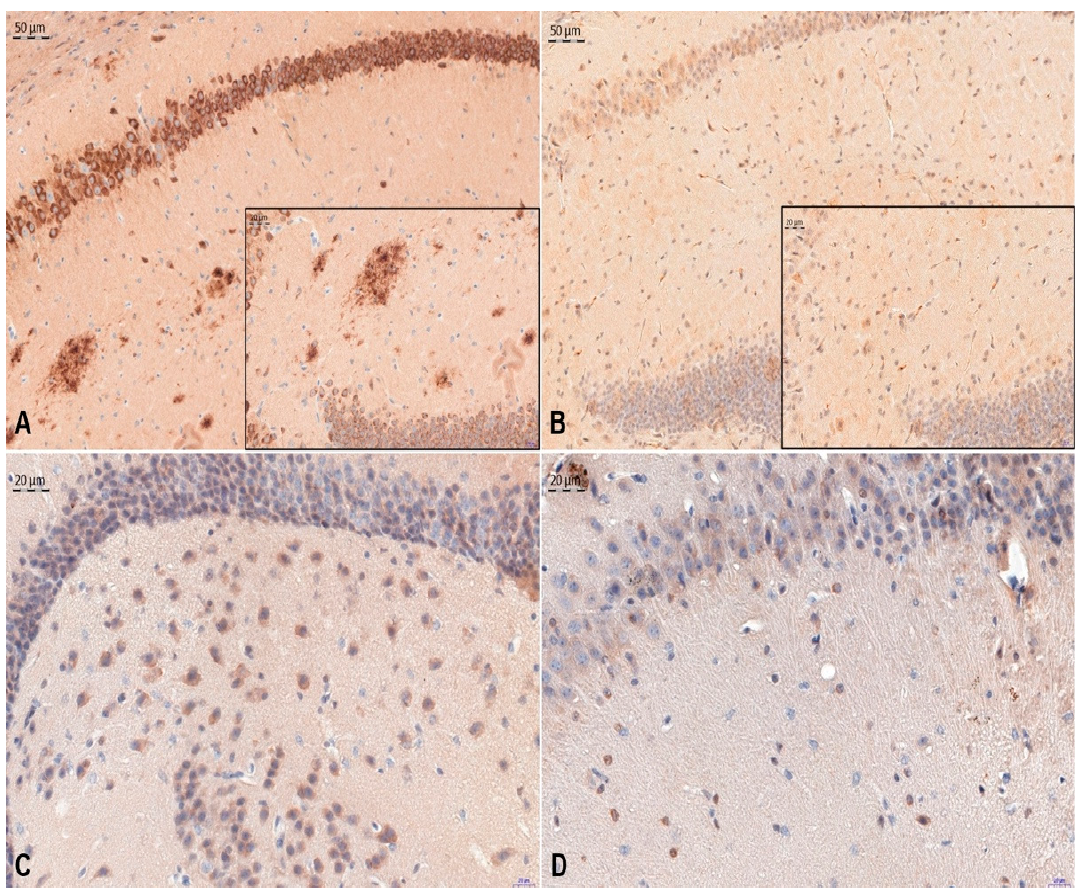
Figure 2. Representative images of immunohistochemical reactions indicating β -amyloid ( A , B ) and TAU-5 ( C , D ) antigen expression were carried out on APP/PS1 + ovCYS group ( A , C ) and NCAR control ( B , D ) mouse brain. Nuclei are stained using hematoxylin. Magnification × 200 ( A , B ) and × 400 ( C , D and